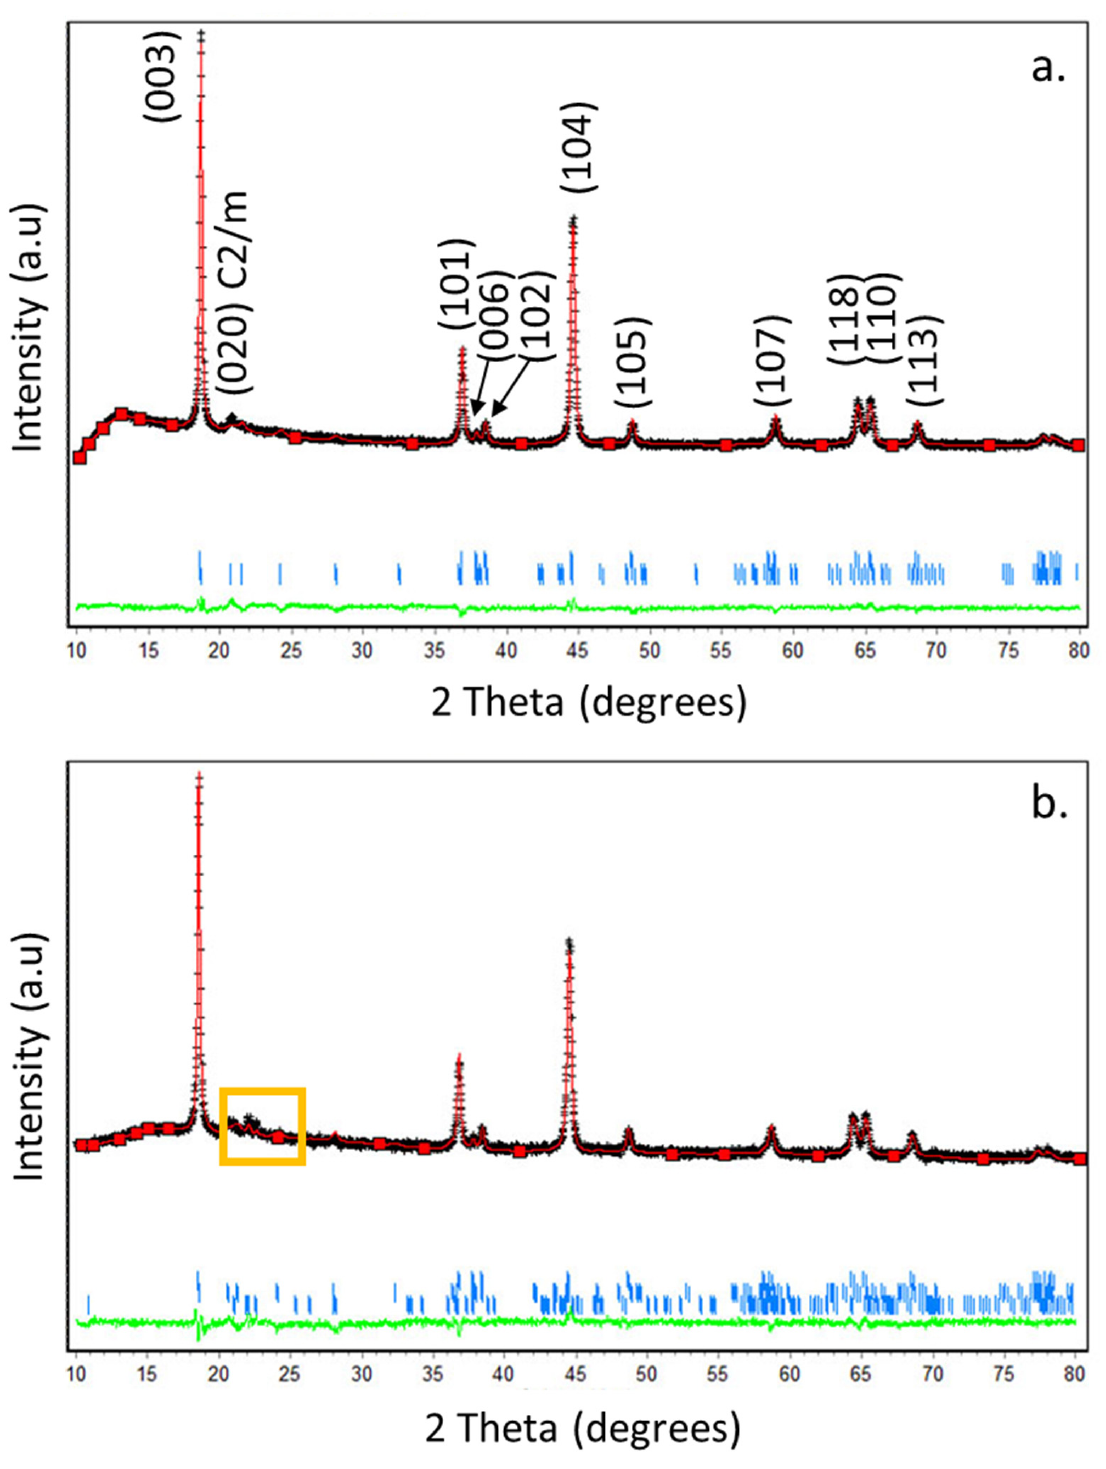
Figure 2. ( a , b ) Rietveld plots for HE-NCM pristine (untreated) material and that treated with Li 2 SO 4 , respectively. The calculated patterns are shown by red curves. The difference between the observed and calculated intensities is presented by the green curve. The short vertical bars indicate the position of Bragg reflections of phases. The yellow square marks the additional most intense peaks of Li 2 SO 4 . Table 1. Lattice parameters of the Li 2 MnO 3 monoclinic ( C2/m ), Li(TM)O 2 rhombohedral ( R-3m ), and Li 2 SO 4 ( P21/a ) phases (components) of HE-NCM materials according to XRD measurements and Rietveld analysis.